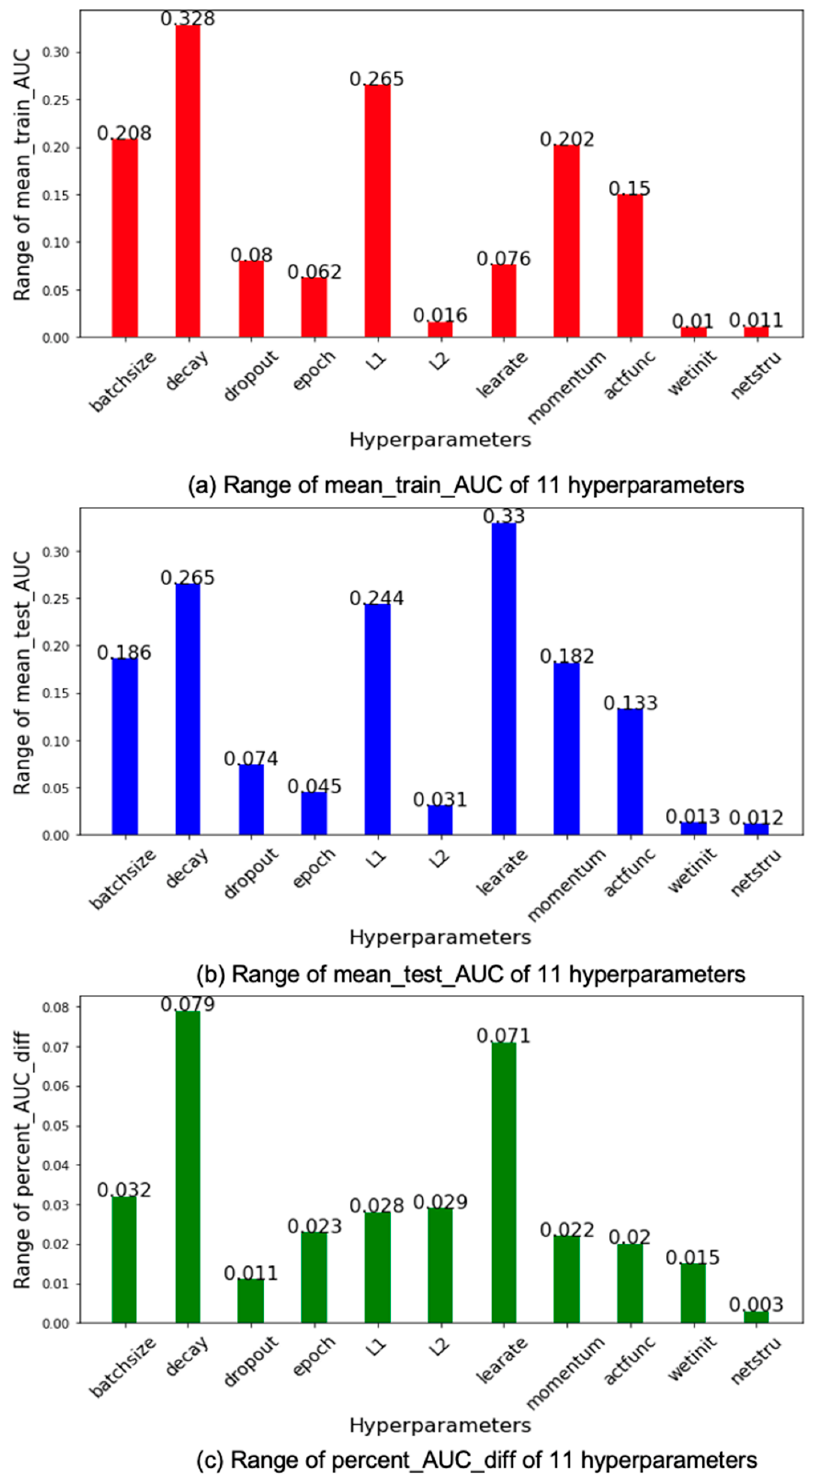
Figure 7. Ranges of the mean_train_AUCs, mean_test_AUCs, and percent_AUC_diff s of the Hy- perparameters.